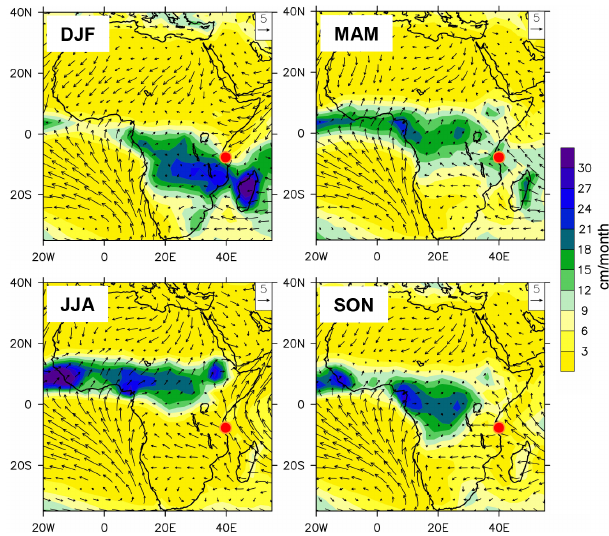
Figure 2. Modern atmospheric circulation over Africa: surface winds (ms − 1 ; Kalnay et al., 1996) and precipitation (cmmonth − 1 ; Adler et al., 2003) are illustrated during austral summer (DJF: De- cember, January, February), autumn (MAM: March, April, May), winter (JJA: June, July, August) and spring (SON: September, Oc- tober, November). The red dot denotes the location of marine sedi- ment core